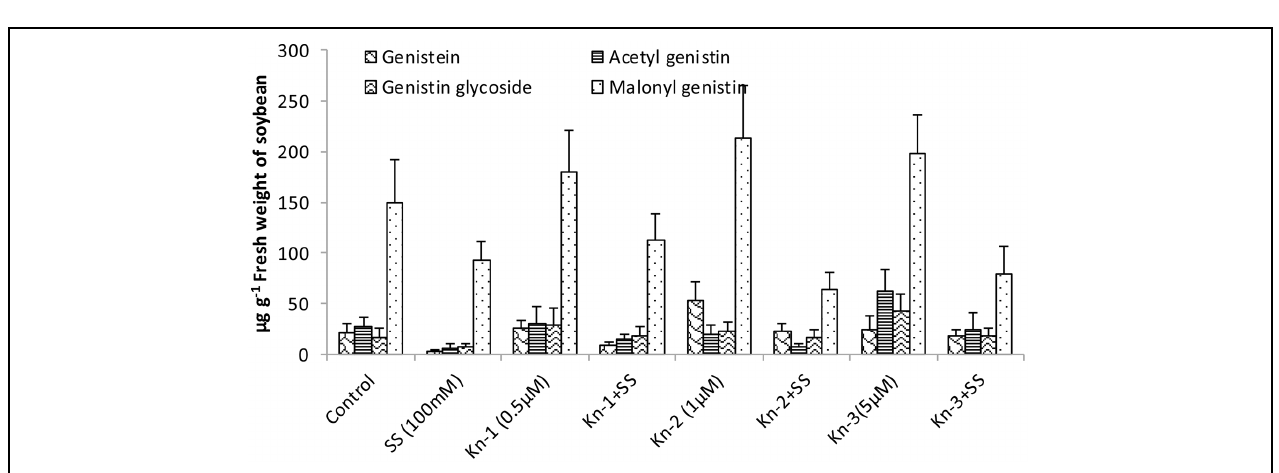
FIGURE 4 | Effect of Kn and salt stress on the concentrations of aglycones, acetyl glycosides, glycosides and malonyl glycosides of genistin in soybean cv. Daewonkong. Bars in the graph represent means of three replicated with ± SEM.